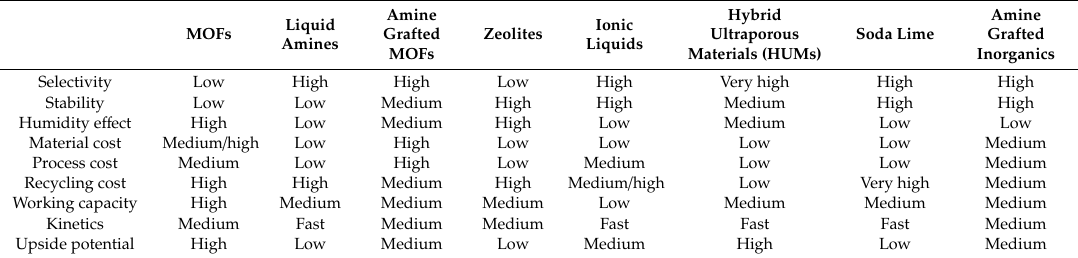
Table 3. Strengths and weaknesses comparison of selected carbon-capture materials [20].